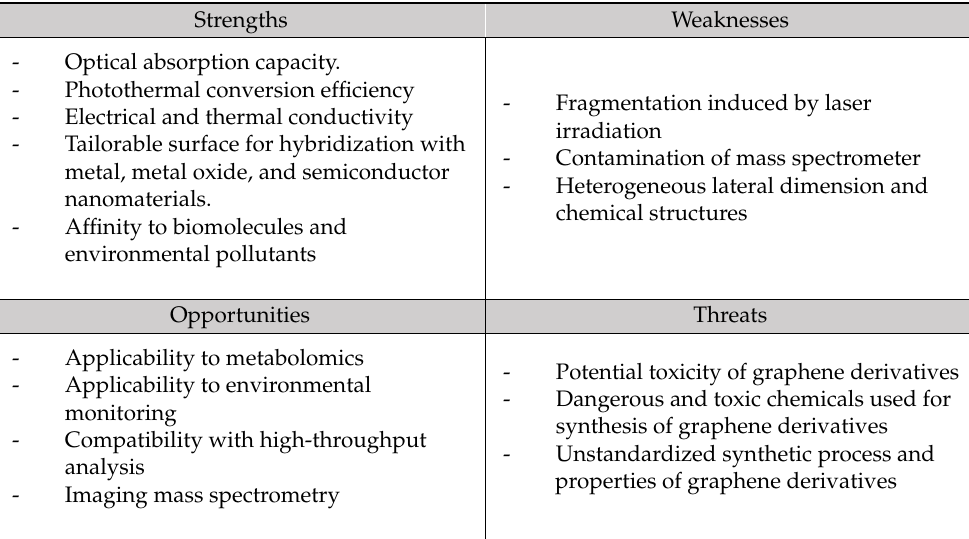
Table 2. A SWOT analysis result of GO derivatives and their nanohybrid structures for LDI-TOF-MS analysis of small molecules. Strengths